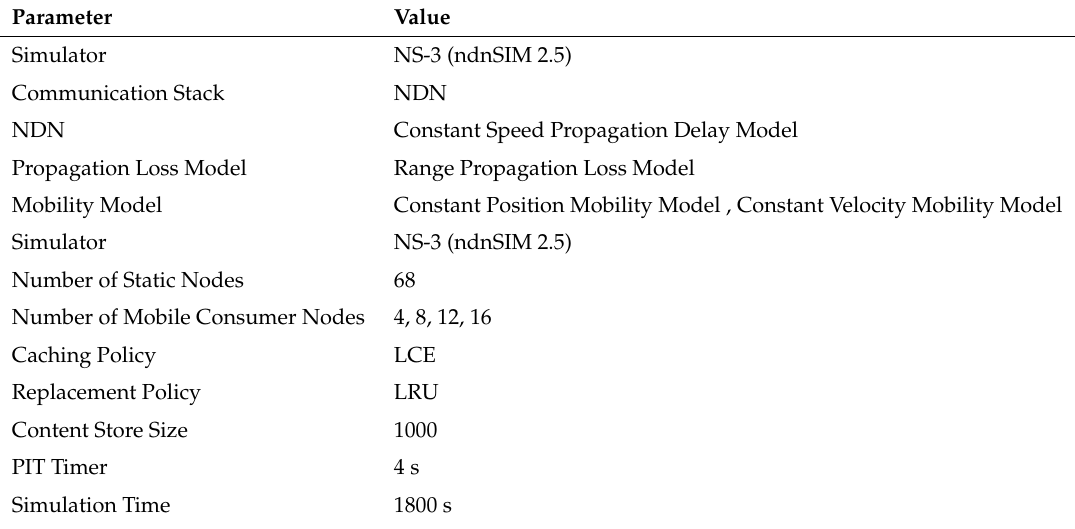
Table 6. Simulation